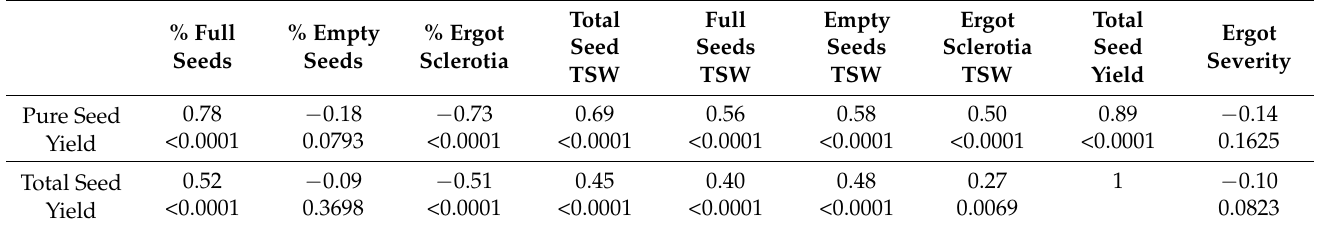
Table 6. Pearson correlation coefficients and probabilities between total and pure seed yield, with seed fractions and seed